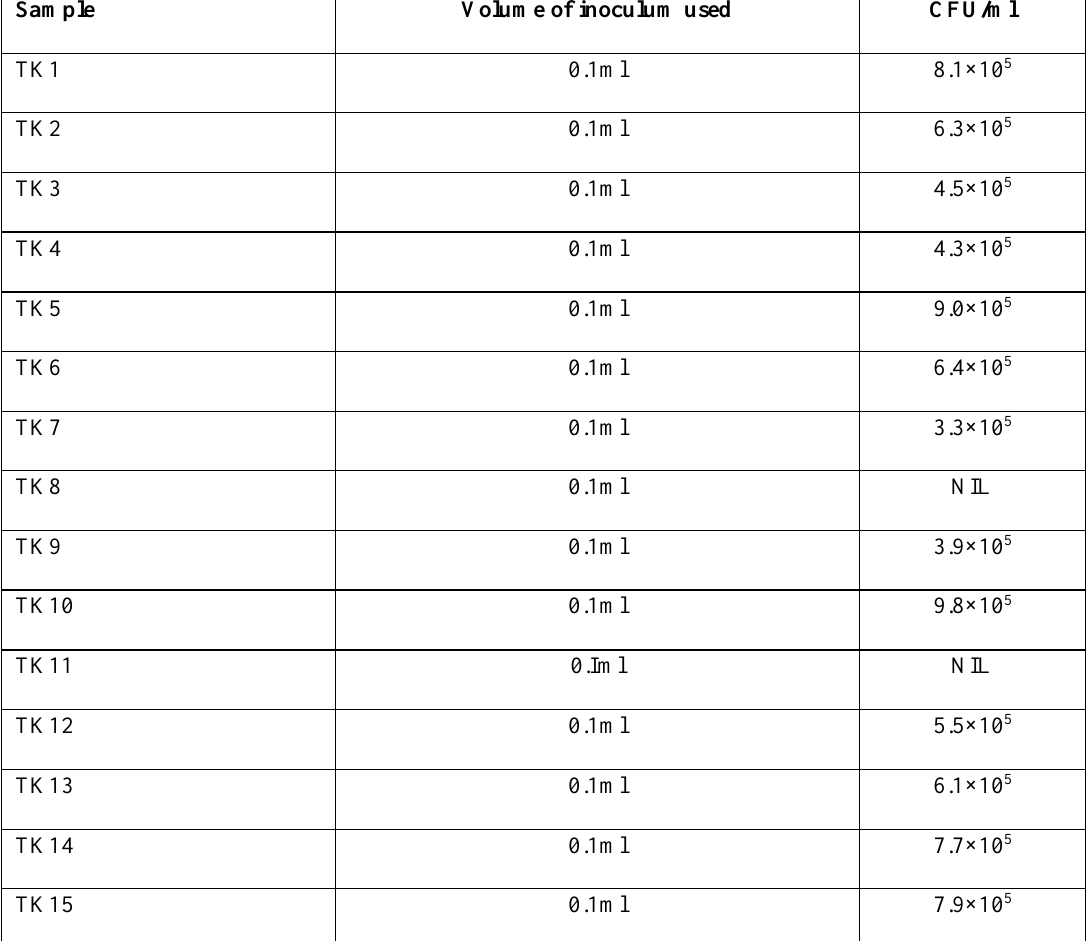
Table 1. Results of total bacterial counts obtained from different packs of disposable plastic cups from old market (tsohuwar